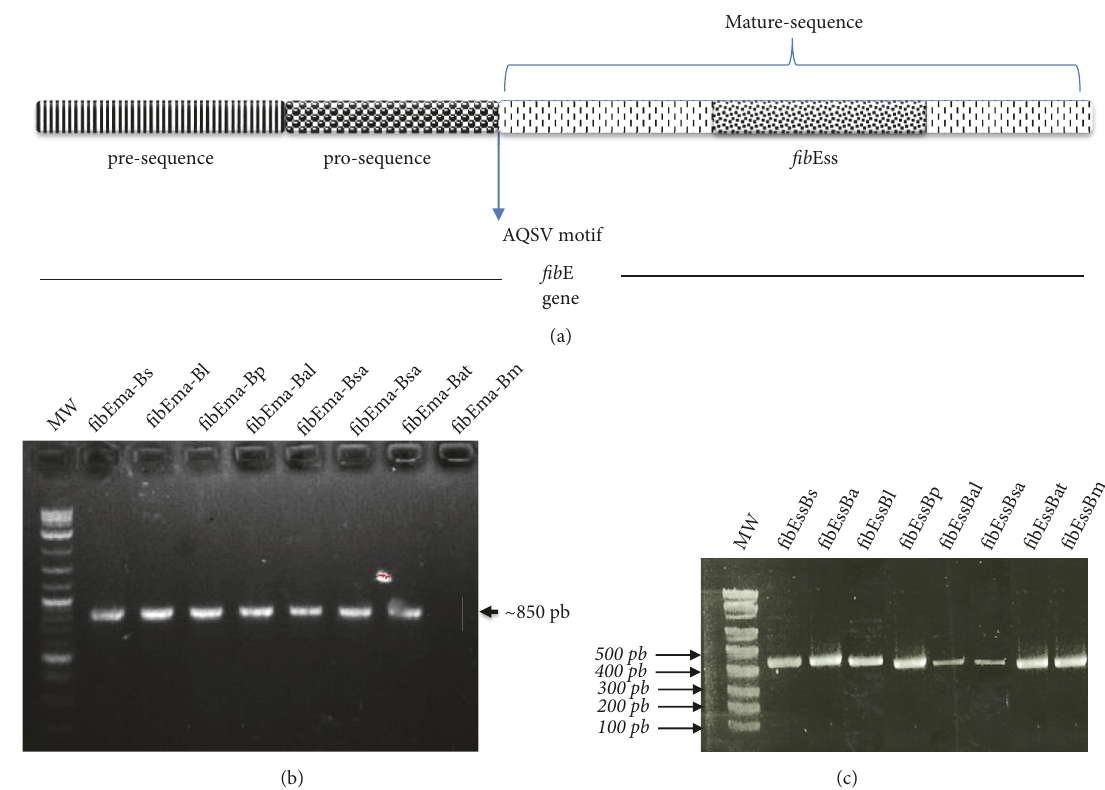
Figure 1: (a) Schematic representation of fib E gene and its corresponding regions, presequence, prosequence, and AQSV motifs by following the mature sequence and internal sequence. (b) Direct identification of the mature sequence fibEma of Bacillus belonging to group 1. MW: molecular weight. (c) Amplification of internal sequence of fibE (fibEss). Bs: B. subtilis . Ba: B. amyloliquefaciens , Bl: B. licheniformis , Bp: Bacillus pumilus , Bal: B. altitudinis , Bsa: Bacillus safensis , Bat: Bacillus atrophaeus , and Bm: B. mojavensis .